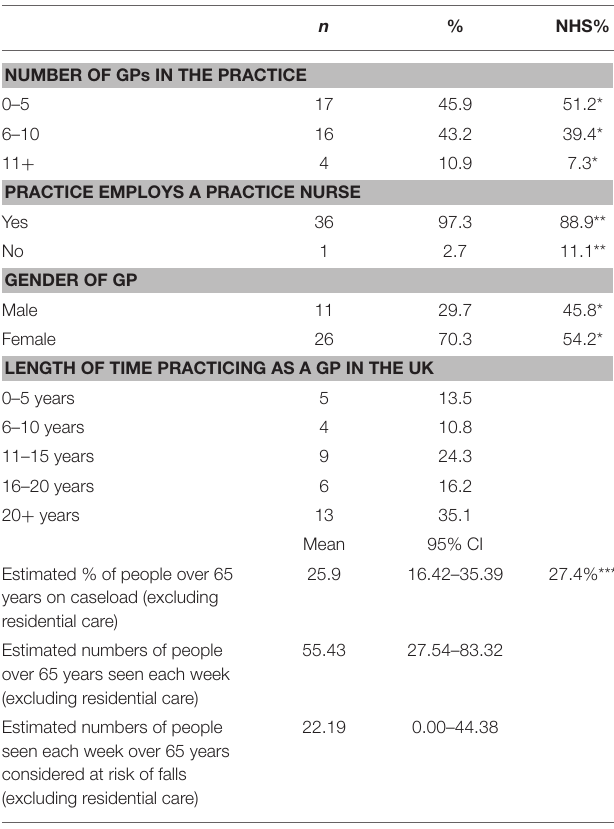
TABLE 2 | Demographics and practice characteristics of survey respondents ( n =